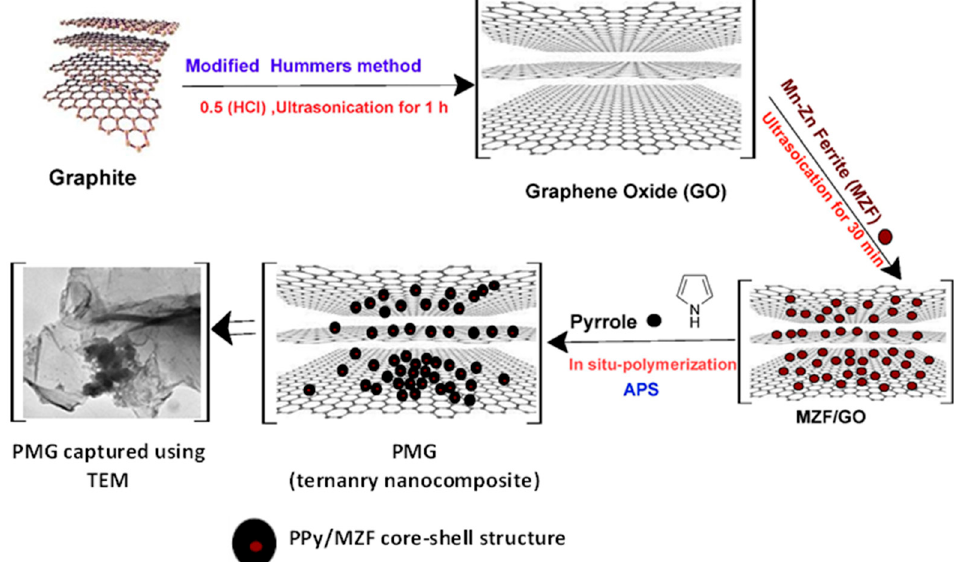
Figure 13. The schematic diagram for illustration of the PMG ternary nanocomposite synthesis.